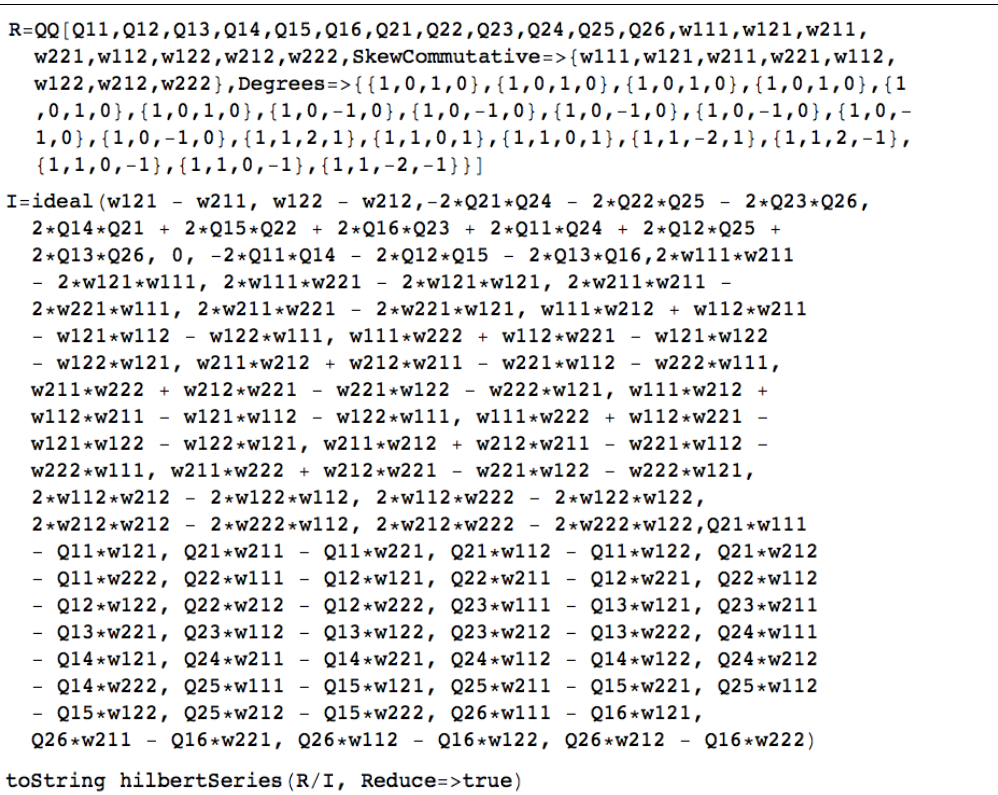
, ( W (cid:11) ) ab , with a as Qai a